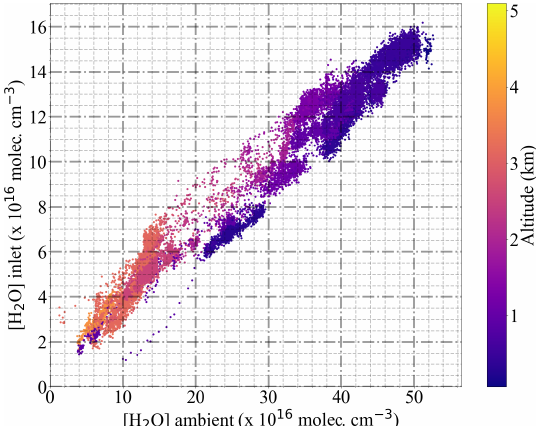
Figure 13. Comparison of the [H 2 O] measured by the BAsic HALO Measurement And Sensor system (BAHAMAS) instrument aboard HALO and inside the DUALER inlet on 17 March 2018 during the EMeRGe campaign in Asia. The colour scale indicates the altitude of the aircraft during the measurement.